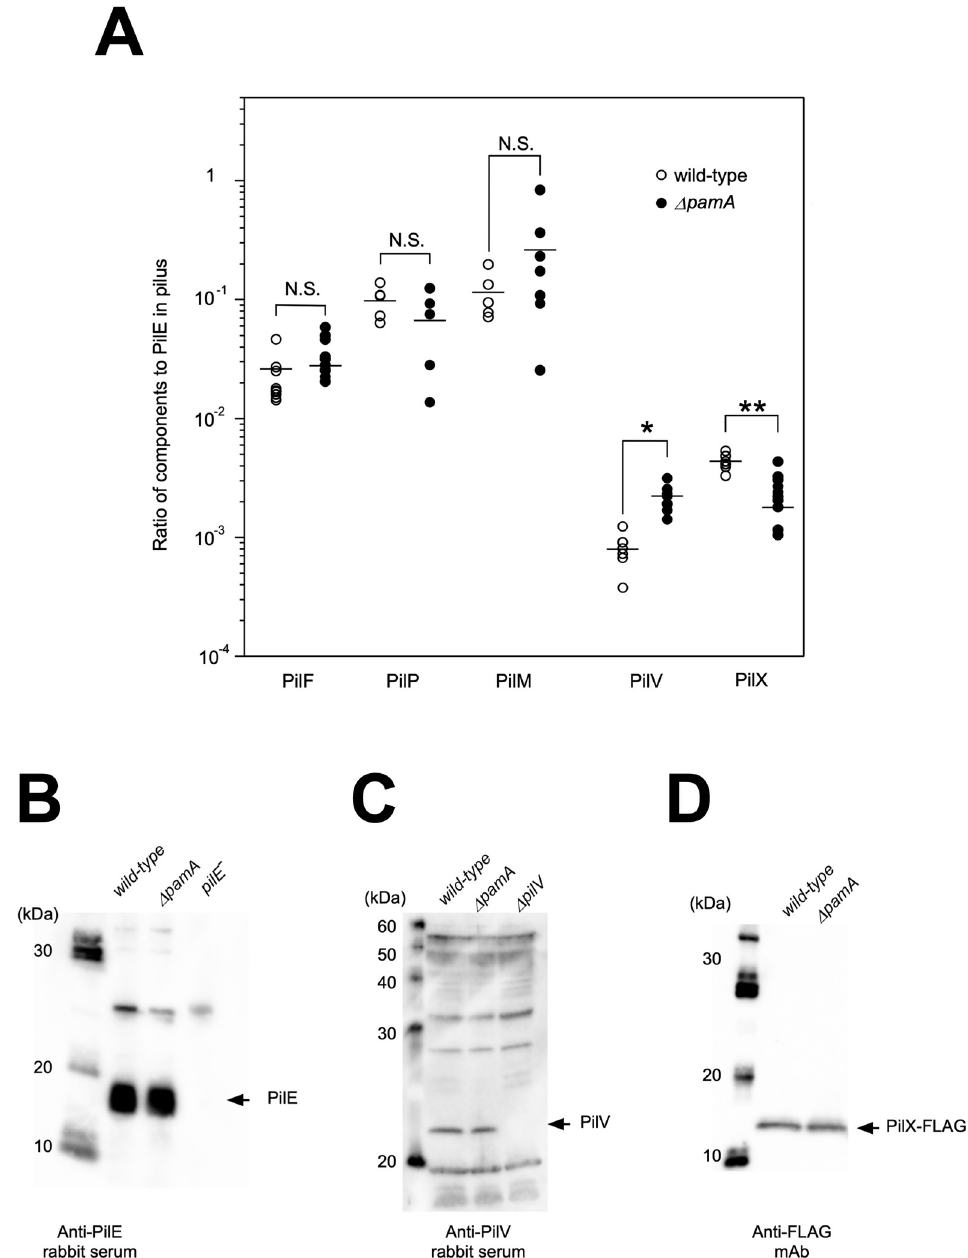
Fig 7. Disruption of the interaction between PamA and PilE leads to abnormal proportions of PilV and PilX relative to PilE in meningococcal pili. (A) Ratio of pilus components to PilE in purified pili. The relative amounts of PilF-FLAG (HT2218 and HT2219), PilP-FLAG (HT2136 and HT2137), PilM-HA (HT2132 and HT2133), PilV (HT1125 and HT1822), and PilX-FLAG (HT2211 and HT2212) to PilE in purified pili were measured by Western blotting with appropriately diluted samples followed by quantification of the band intensity using the 30-kDa band in the molecular marker as an internal golden standard. The values obtained were divided by the value of PilE in the same sample. The significance of differences was examined by the t-test. (B, C, D) The pamA mutation does not affect the expression of the PilE (B), PilV (C), or PilX-FLAG (D) protein in N . meningitidis . Bacterial extracts equivalent to OD 600 value of 0.0025 (for PilE) or 0.05 (for PilV and PilX-FLAG) were analyzed by Western blotting with anti-PilE and anti- PilV rabbit sera, and an anti-FLAG mAb, respectively. Black arrows indicate PilE, PilV, and PilX-FLAG,